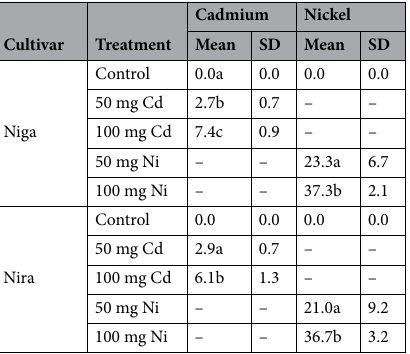
Table 1. Cadmium and nickel concentration in leaves [mg × kg −1 D.M.] ± S.D of two perennial ryegrass turf cultivars (‘Niga’ and ‘Nira’) under different Ni and Cd treatment (0; 50 and 100 mg × 100 g −1 of substrate). Means within one cultivar marked by different letters represent statistically significant differences ( p < 0.05, n =